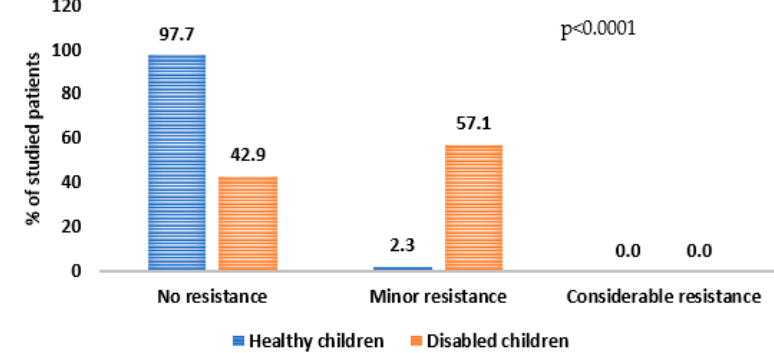
Figure 2. Interpretation of mirror test results in selected groups of children.